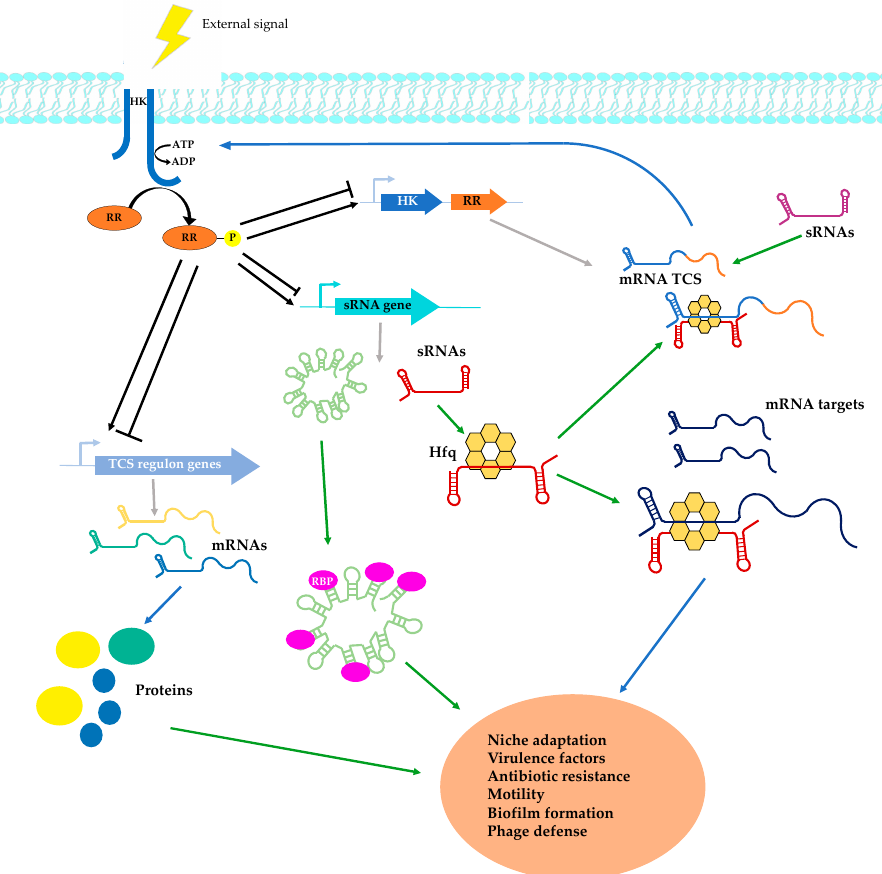
Figure 1. Interplay between regulatory sRNAs and two-component systems during bacterial